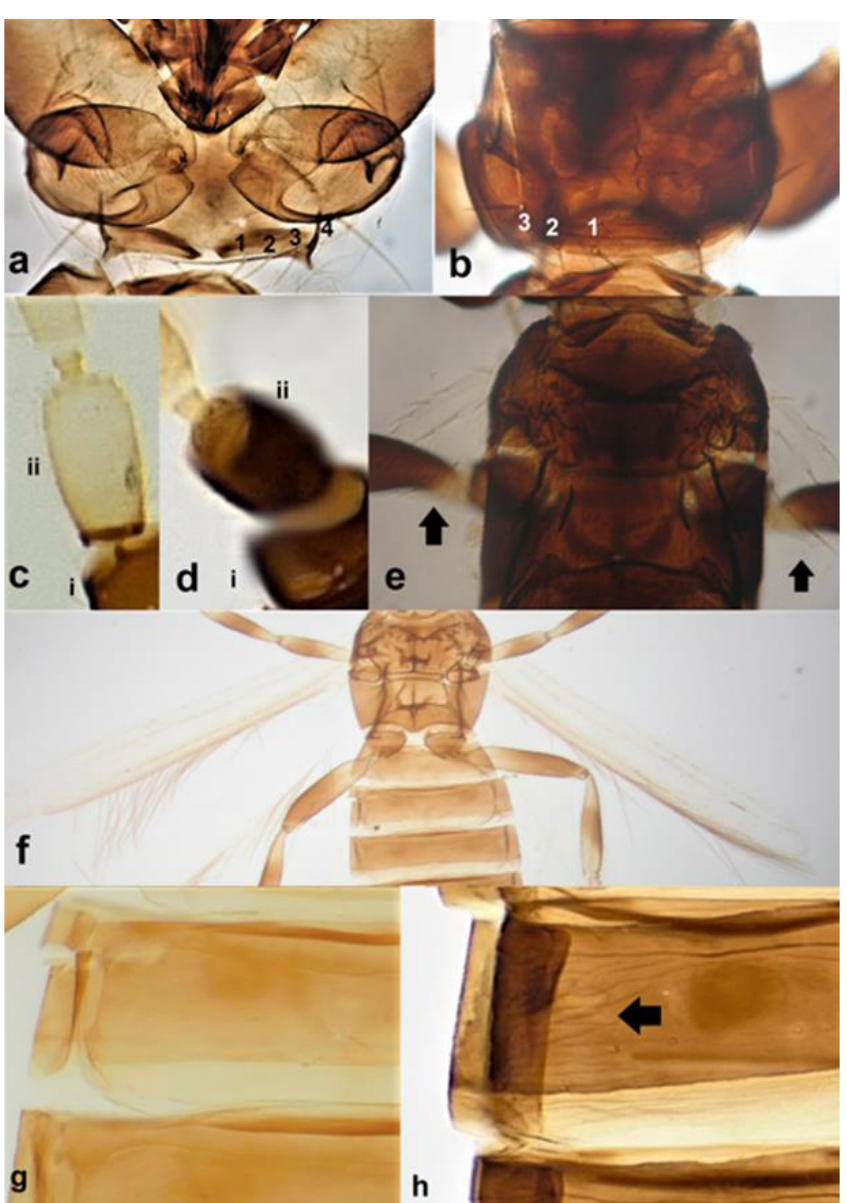
Antennal segment II yellow (Figure 10c); pronotum yellow to light brown and with three to four long pairs of postero-marginal setae (Figure 10a); females always macropterous (Figure 10f); abdominal tergites with little or no sculpture or microtrichia (Figure 10g) ………………………………… Rhipidothrips gratiosus Uzel. Antennal segment II brown (Figure 10d); pronotum brown and with two to three long pairs of postero-marginal setae (Figure 10b); females usually micropterous (Figure 10e); abdominal tergites sculptured, sometimes lined with microtrichia (Figure 10h) .... 10